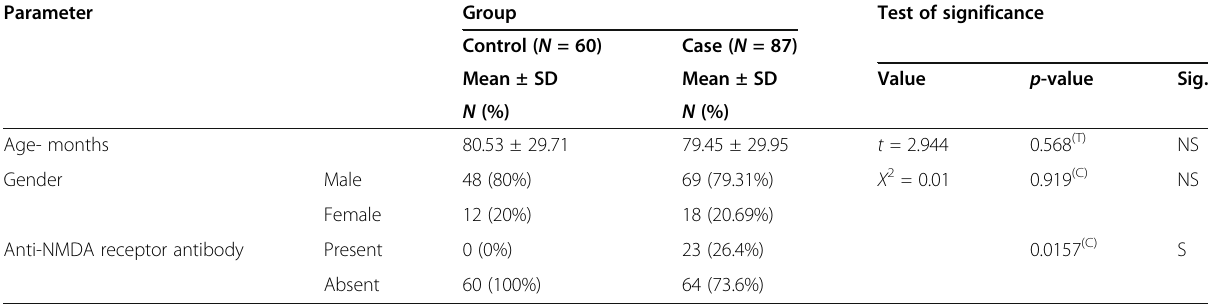
Table 1 Sociodemographic data and presence of anti-NMDA receptor antibody in the control and patient groups of the study Parameter